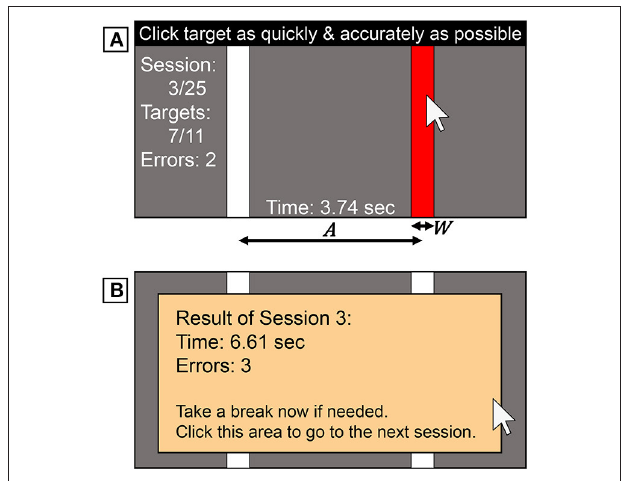
FIGURE 2 | Task stimuli used in the experiment. (A) Participants clicked alternately on each target when it was red. (B) At the end of a session, the results and a message to take a break were